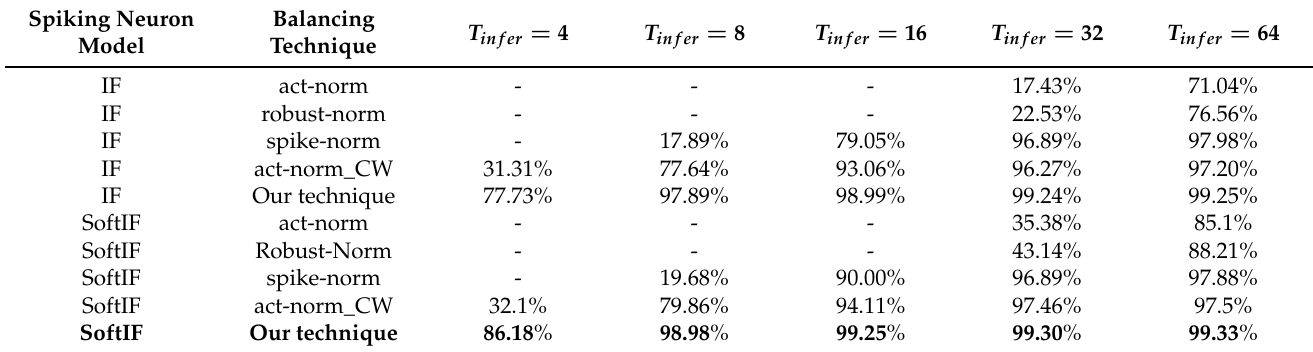
Table A4. Ablation study for spiking neuron model and threshold balancing technique on the MNIST